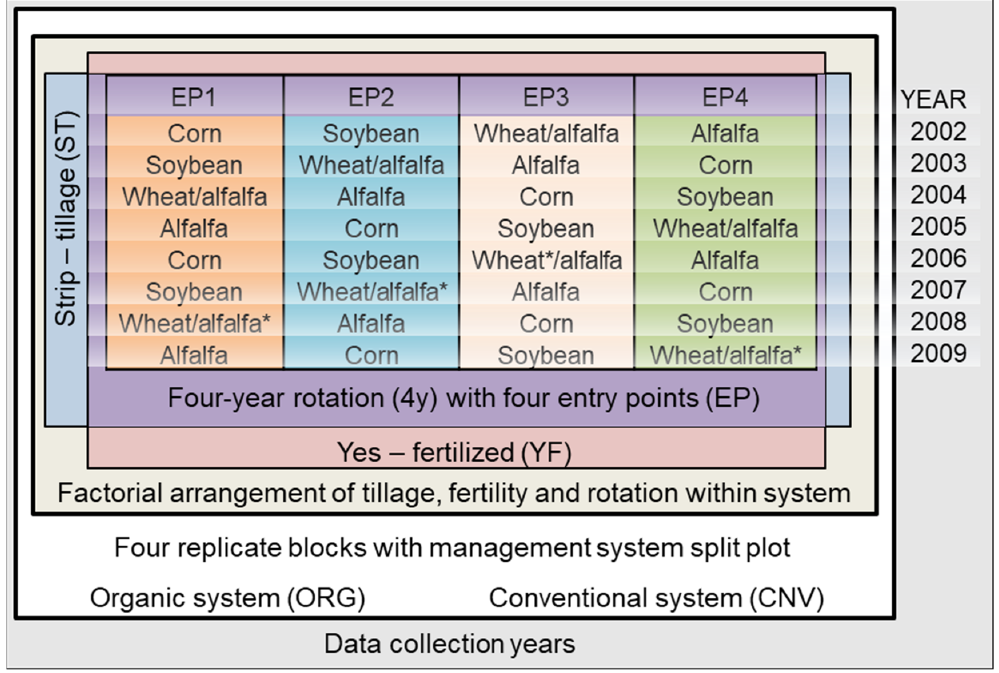
Figure 2. Randomized complete split-block experimental plot design emphasizing entry point (EP) factor within the 4y rotation treatment. Each of the four entry points (EP1, EP2, EP3, and EP4) represents a four-year crop rotation sequence that was repeated twice over eight years (2002–2005 and 2006–2009). Outer most gray box shows data collection years aligned with rotation sequence of crops. Inner white box indicates one of four replicate blocks, split by management system. Next inside, the o ff -white box represents the factorial arrangement of rotation (purple box), strip-tillage (blue box), and yes-fertilized (pink box) treatment factors, that were established in both management systems. Thus, all four EP treatments within both organic (ORG) and conventional (CNV) splits in each of four replicate blocks yielded 32 experimental units. * Wheat in ORG-EP3 was not under-seeded with alfalfa in 2006; alfalfa only was planted in ORG-EP2, ORG-EP1, and ORG-EP4, respectively, from 2007 to 2009.